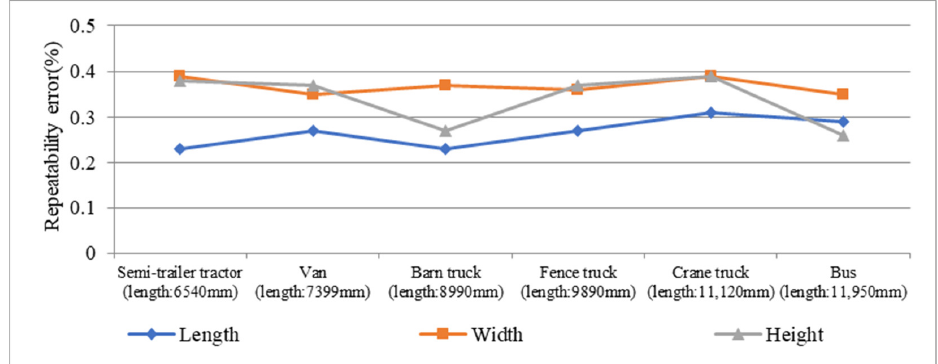
Figure 18. Max relative error of profile size of the five vehicles. Figure 19. Repeatability error of profile size of the five vehicles.